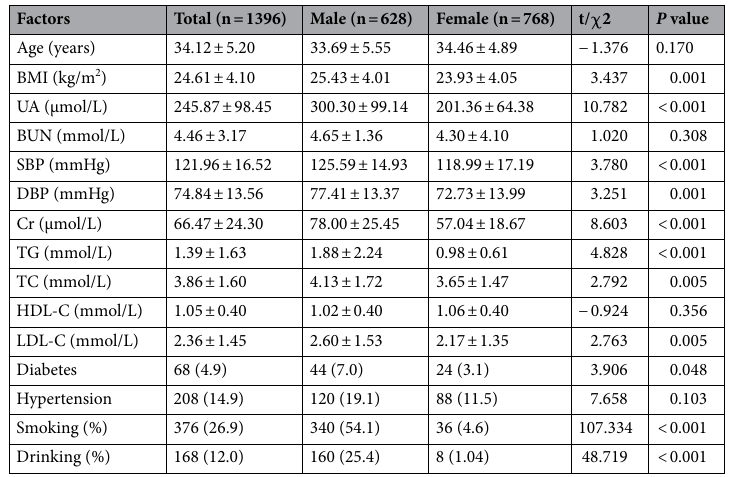
Table 1. Clinical and metabolic characteristics of subjects. Continuous variables are expressed as mean ± SD. Categorical variables are expressed as percentages. BMI body mass index, TG triglyceride, TC total